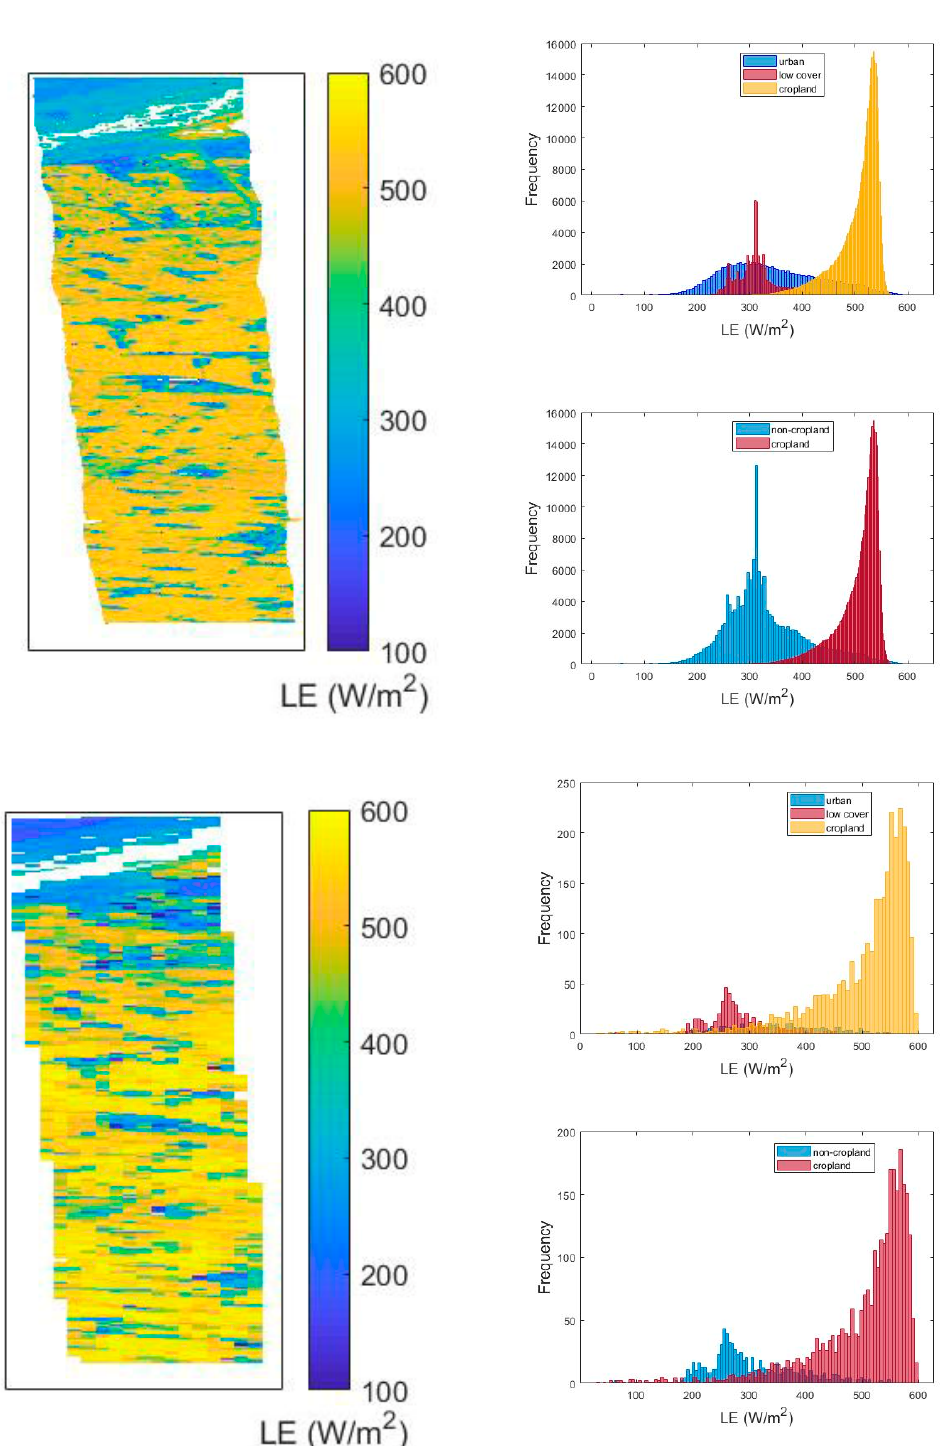
Figure 4. Comparison between ASTER-derived ET (90 m, lower-left) and ET derived from aircraft image Track 8-2 (7.5 m, upper-left) maps and the associated histograms of the three main land cover types, alternatively combining urban and low canopy cover (semi-arid natural vegetation) under the broad land cover category of non-cropland.